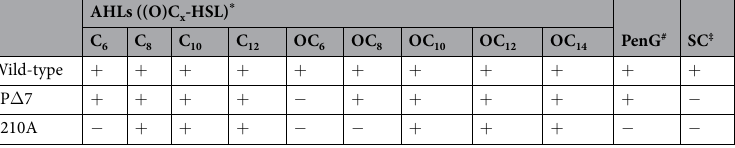
Table 1. Summary of AHLs/penicillin G degrading activity of wild-type MacQ and the mutants, SP Δ 7 and S210A. * Abbreviations of AHLs are: C 6 -HSL, N -hexanoyl-l-homoserine lactone; C 8 -HSL, N -octanoyl-l- homoserine lactone;